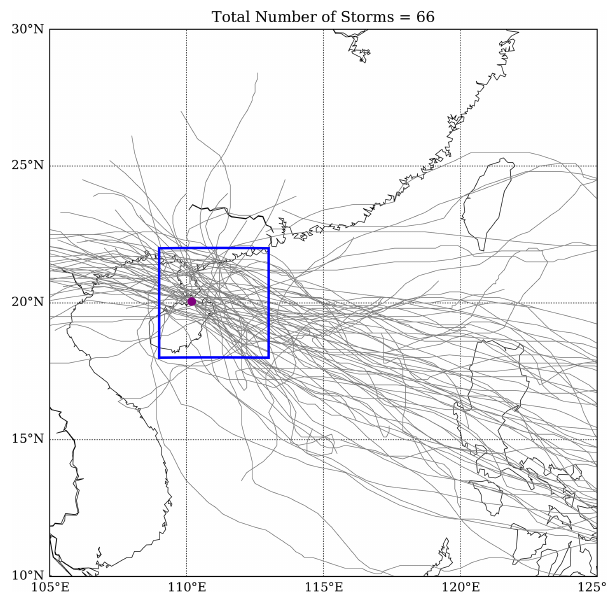
Figure 2. Location map for the study area. Purple dot indicates the location of Haikou. Grey coloured lines indicate major historical TC tracks within the region. Blue box indicates the selection region (18–22 ◦ N, 109–113 ◦ E).